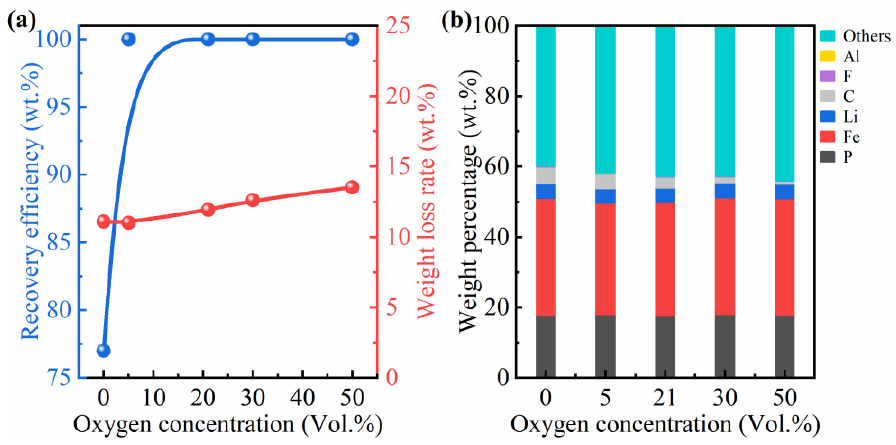
Figure 7. Effect of oxygen concentration on ( a ) recovery efficiency of cathode materials, weight loss rate of cathode plates, and ( b ) element content in calcined cathode materials.